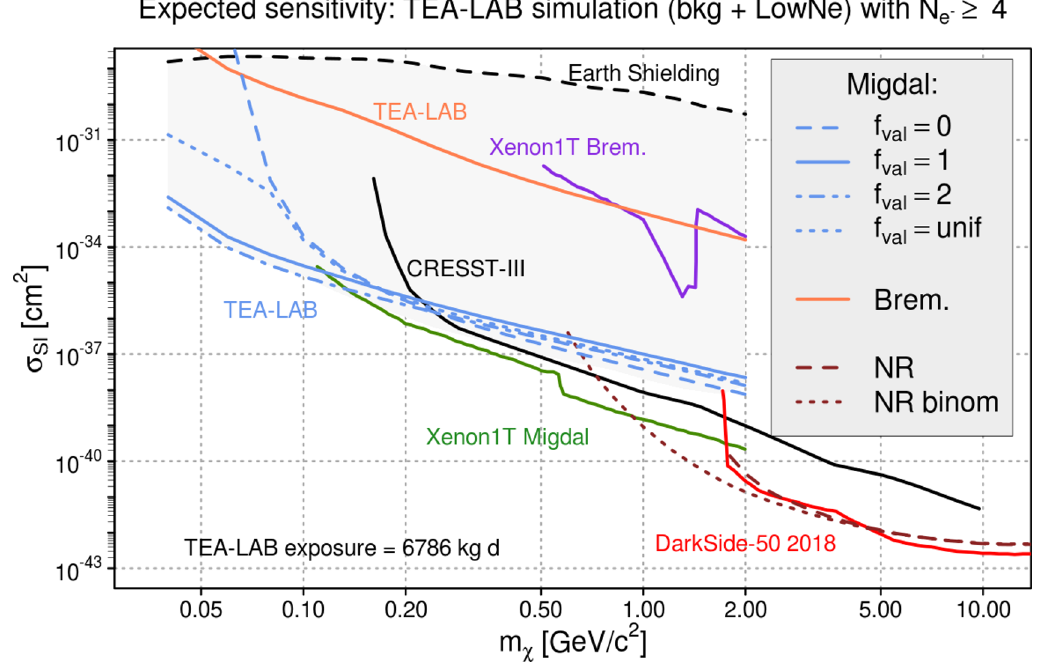
Figure 5 . 90% C : I : upper bounds on the (cid:27) SI exploiting the Migdal electron and photon Bremsstrahlung signals for the tea-lab simulated experiment loosely inspired by DarkSide-50. These results are obtained using and exposure E = 6786 kg d , and simulating a